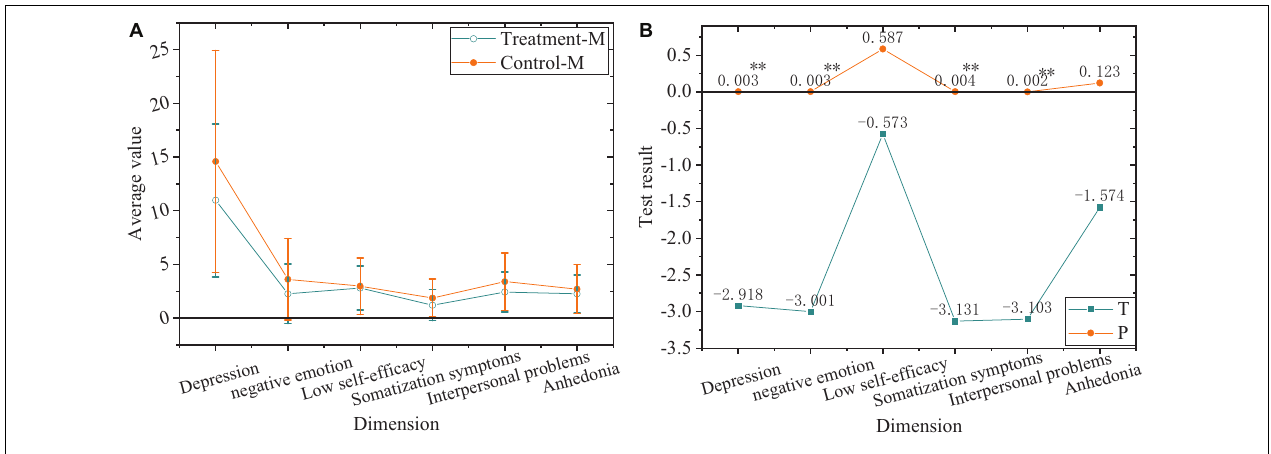
FIGURE 9 | Comparison of negative emotions. (A) Values of the treatment group and control group after the experiment. (B) Value of T and P of the treatment group and control group after the experiment. “ ∗ ”Means a significant difference, while “ ∗∗ ” signifies a highly significant difference.